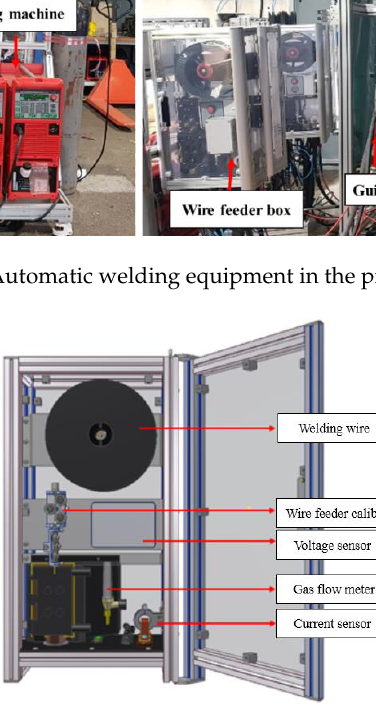
Figure 3. Construction of the wire feeder box.